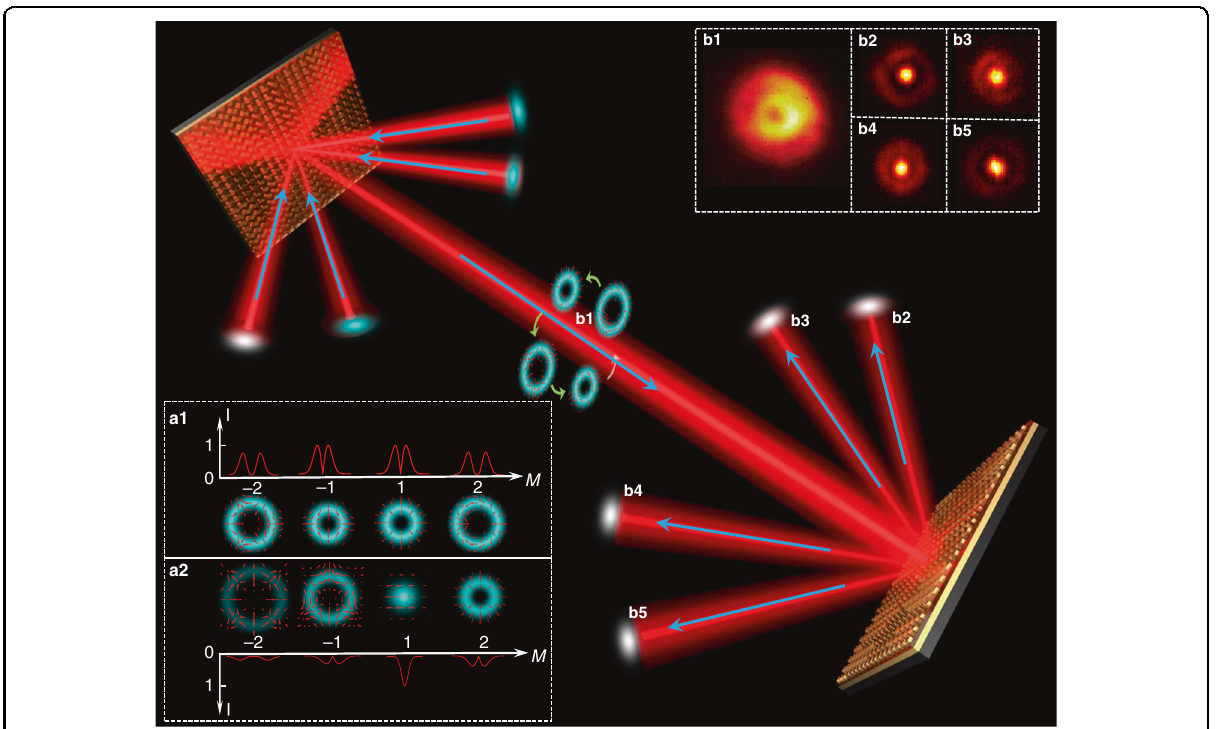
Fig. 4 Schematic of CVB modes multiplexing/demultiplexing by using metasurface-based Dammann optical vector gratings. a1 Polarization and intensity distributions in each diffraction order with Gaussian beam incident, respectively. a2 Polarization and intensity distributions in each diffraction order with CVB ( m = − 1) incident. b1 Measured coaxial CVB with 4 modes ( m ¼ ± 1 ; ± 2); b2 − b5 measured Gaussian points after demultiplexing of the different CVB mode